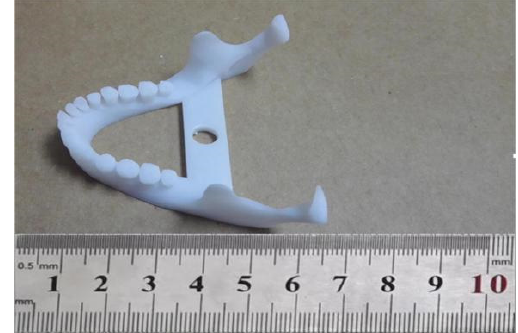
Figure 6. The cantilever AM platform.